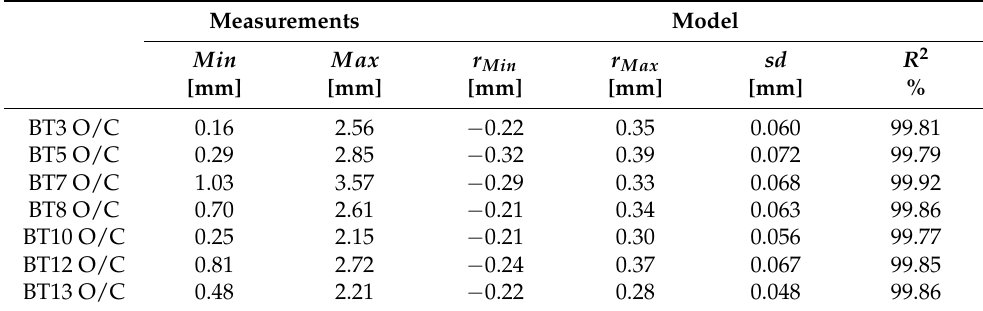
Table 2. MLP model performance